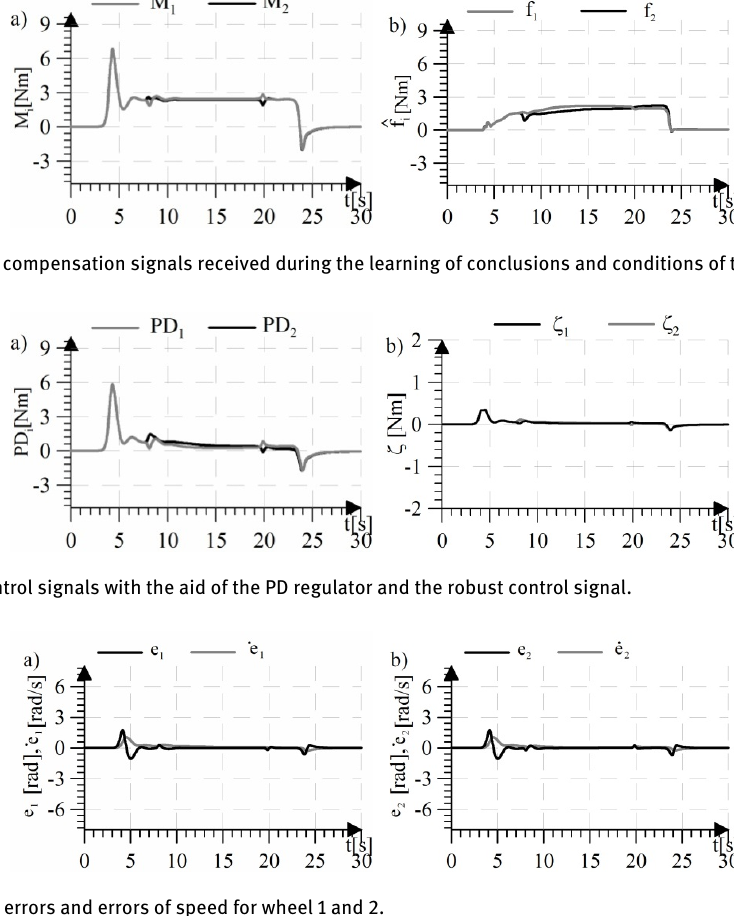
Figure 4: The course of lag errors and errors of speed for wheel 1 and 2.